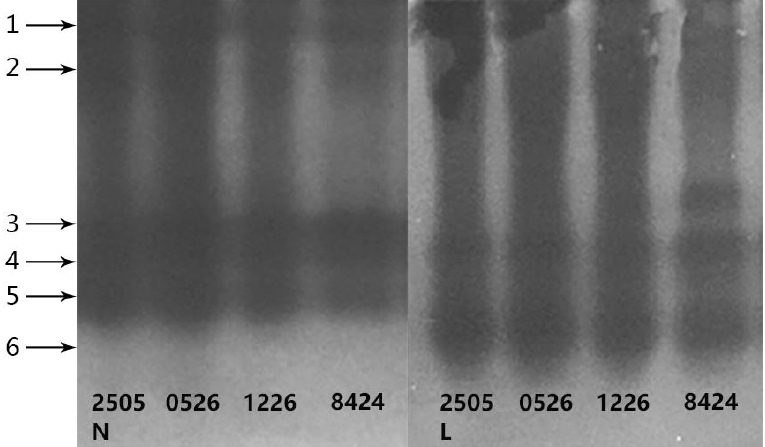
Figure 4. CAT isozymes in leaves of different grafted seedlings (different numbers represent different bands).